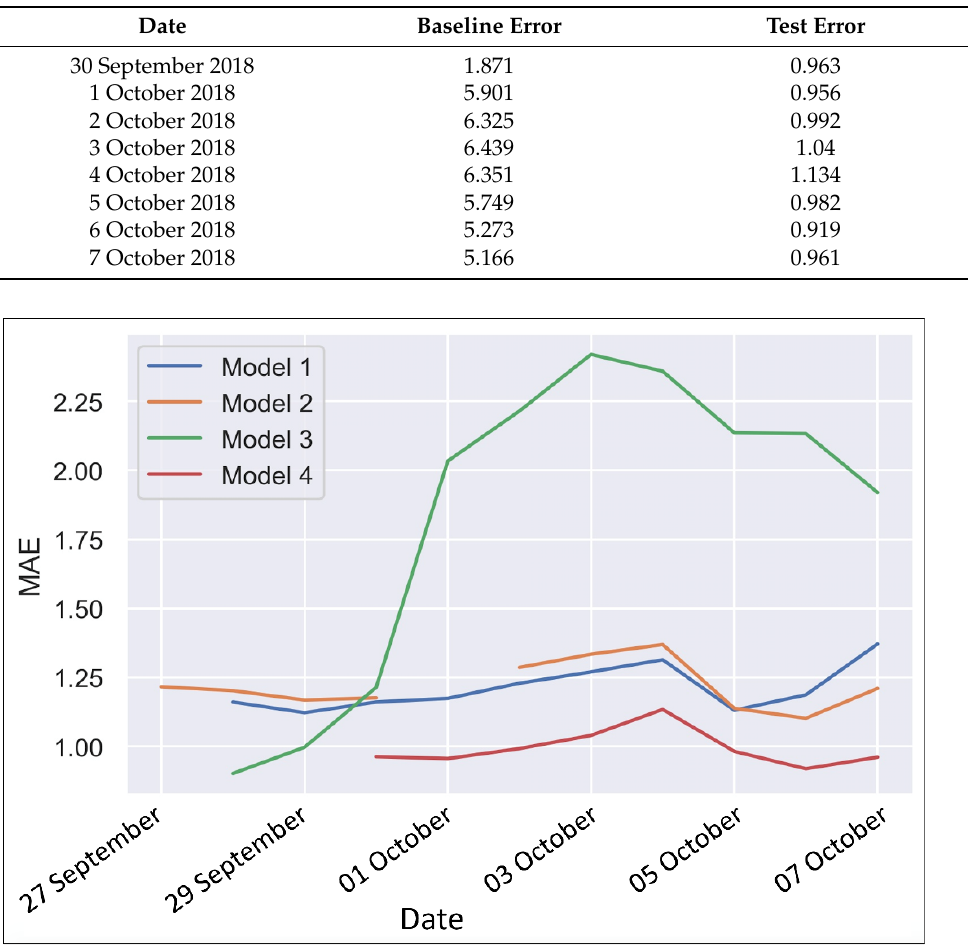
Figure 9. The plot of daily test errors of model-1, 2, 3, 4.